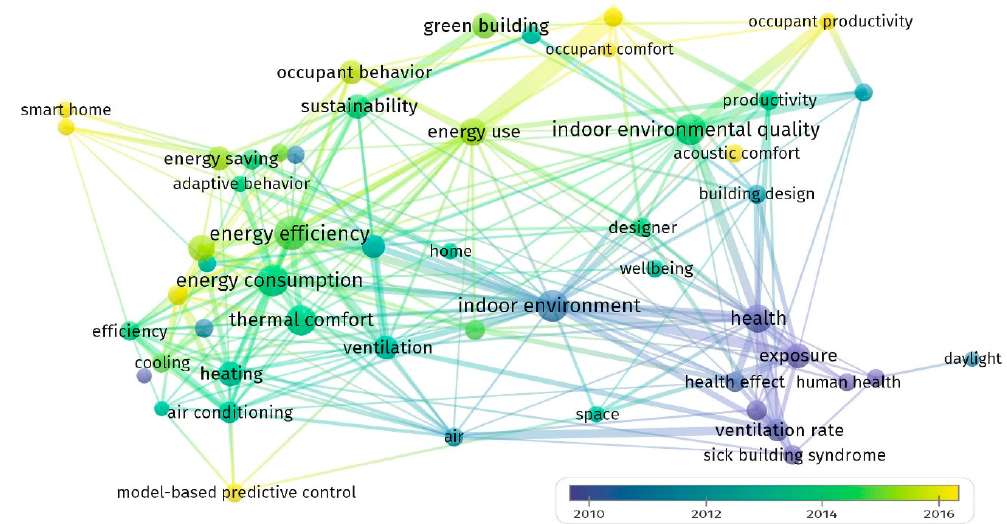
Figure 4. Keyword network visualization on co-occurrence and link strength of terms extracted from abstracts of review papers, color scale based on the average year of publication.